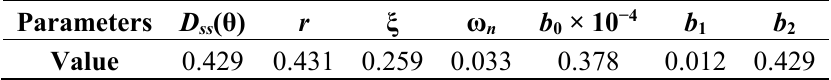
Figure 5. The aggregated demand response of a 0.5 °C step based on the second-order linear time invariant (LTI) model. Table 1. Parameters of two order linear time invariant transfer function.